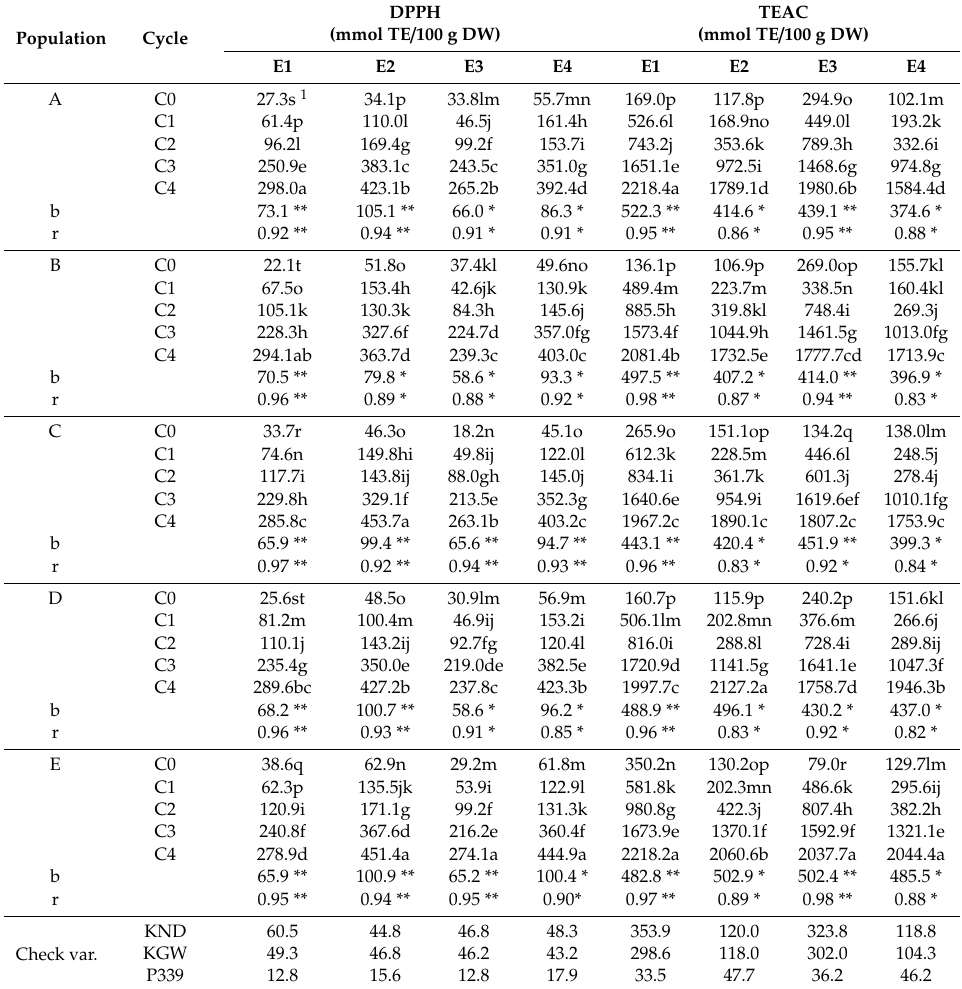
Table A6. Means for antioxidant activity determined by the DPPH and the TEAC methods of (A–E) five populations and (C0–C4) five cycles in husk evaluated in four environments.